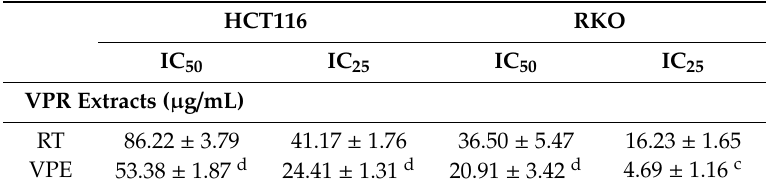
Table 2. IC 50 and IC 25 values of vine pruning residue (VPR) extracts in HCT116 and RKO cells after 48 h of treatment (expressed in μ g/mL).